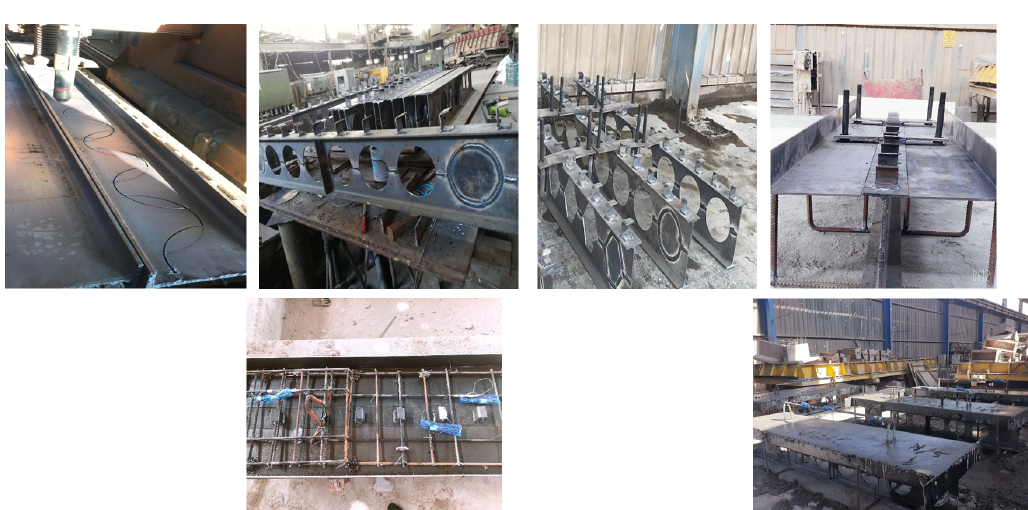
Plate 1: Fabricated and cast of the composite cellular